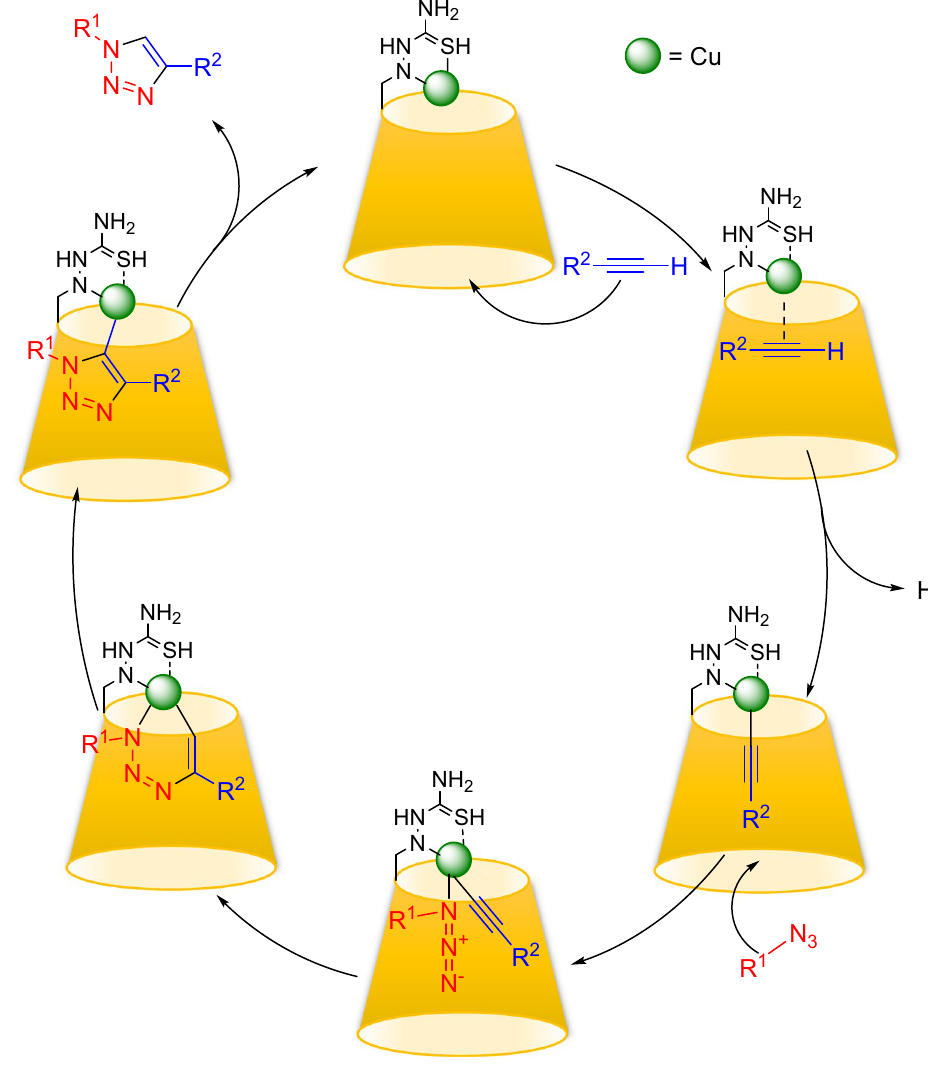
Scheme 2. The catalytic mechanism for the copper-catalyzed alkyne/azide cycloaddition to form